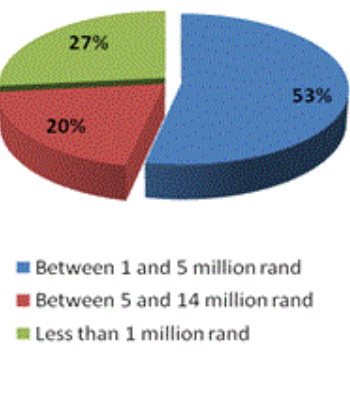
Figure 4: Turnover per respondent